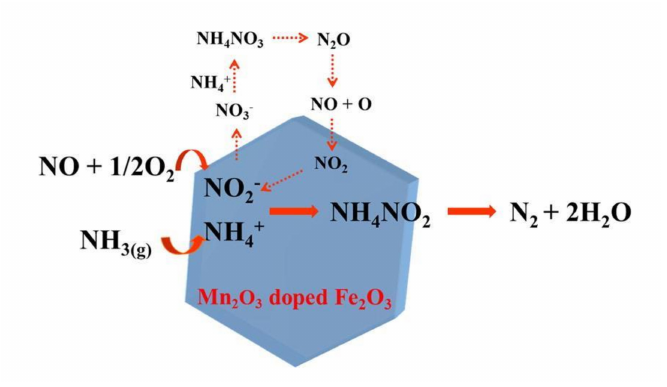
Figure 14. The reaction mechanism of the MnFeO x catalyst